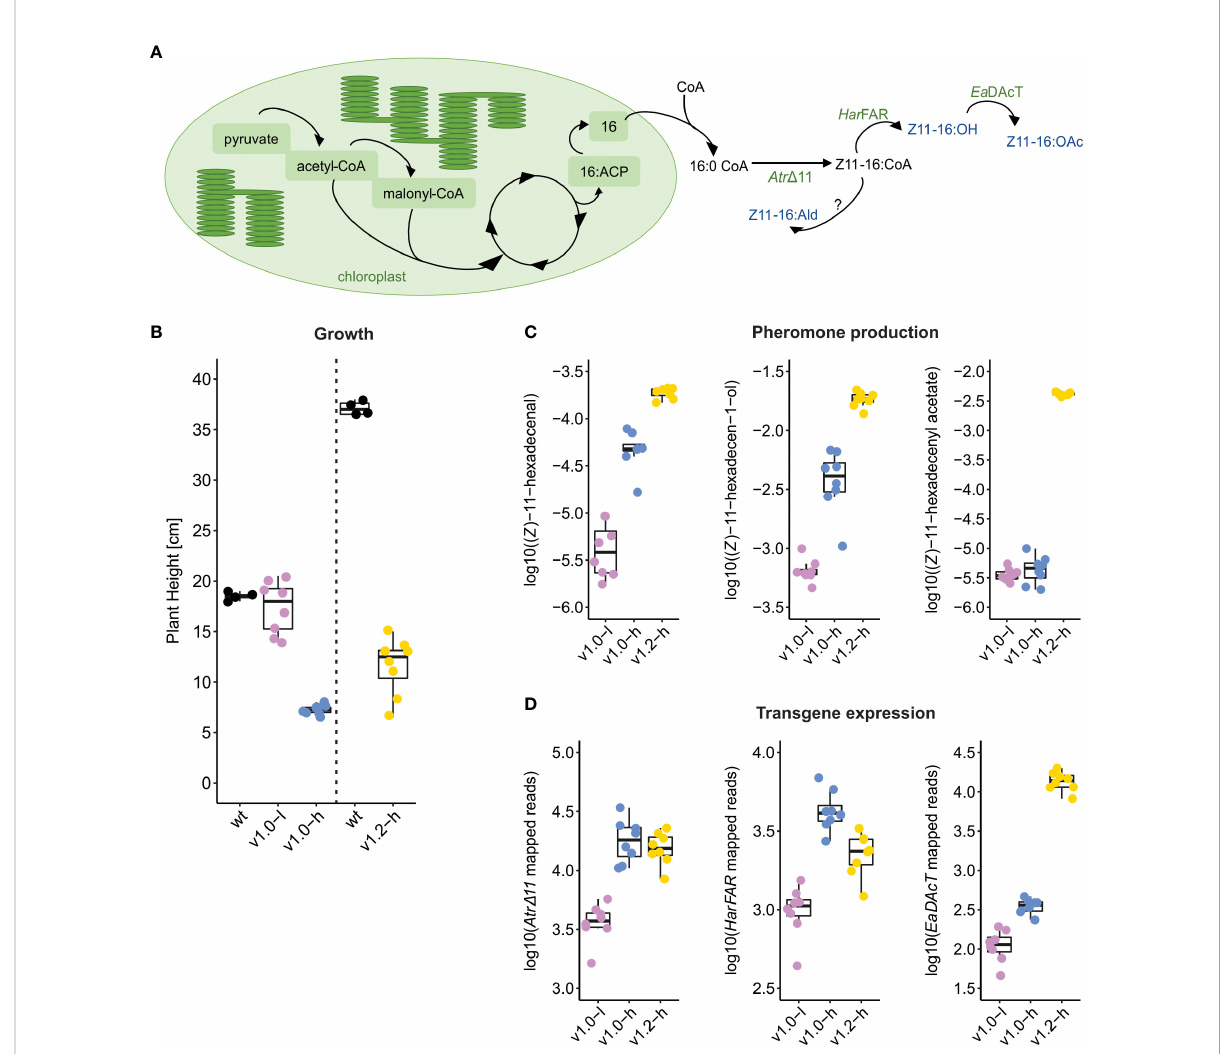
FIGURE 1 Design and phenotype of SxP. (A) Schematic representation of lipid-derived moth pheromone biosynthesis in SxP. Transgene-expressed enzymes are shown in green ( Atr D 11, Har FAR, and Ea DAcT) and the produced pheromones in blue (Z11-16:OH — ( Z )-11-hexadecen-1-ol, Z11-16: OAc — ( Z )-11-hexadecenyl acetate, Z11-16:Ald — ( Z )-11-hexadecenal, resulting from conversion with an unknown endogenous oxidase, as denoted by “ ? ” ). (B – D) Boxplots of plant height (B) , pheromone content (C) , and transgene expression (D) in SxP and wt N. benthamiana plants, selected for RNA-Seq analysis. Plants for sampling of SxPv1.0 and SxPv1.2 were grown in separate experiments, indicated by the dashed vertical line in (B) . Pheromone production in SxP (( Z )-11-hexadecenal, ( Z )-11-hexadecen-1-ol, and ( Z )-11-hexadecenyl acetate) was measured as area under the curve on GC/MS plots, normalised with total ion count (TIC) and log 10 transformed. Transgene expression ( Atr D 11 desaturase, HarFAR reductase, and EaDAcT acetyltransferase) is given as normalised total counts of reads per kilobase of transgene sequence. Sample groups in all boxplots: v1.0-l — SxPv1.0 low producers (purple), v1.0-h — SxPv1.0 high producers (blue), v1.2-h — SxPv1.2 high producers (yellow), N = 8 and wt (black), N=4. Growth and pheromone content for all the grown plants in the experiments are shown in Supplementary Table S1 and Supplementary Figure